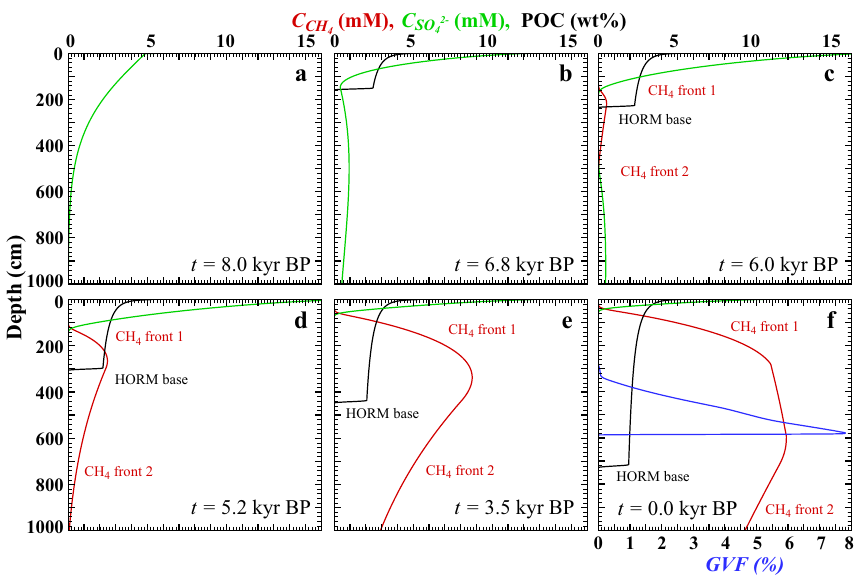
Fig. 7. Concentration time slices of POC (black), dissolved methane (red), sulphate (green) and free methane gas (blue) for Station A5. Time slices times are indicated in each panel. (a) t = 8 . 0kyrBP (start of organic matter deposition). (b) t = 6 . 8kyrBP (similar to current settings at Station A1). (c) t = 6 . 0kyrBP (timeframe showing a double SMTZ). (d) t = 5 . 2kyrBP (similar to current settings at Station